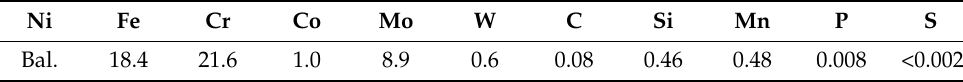
Table 1. Chemical composition of Hastelloy X base plate,